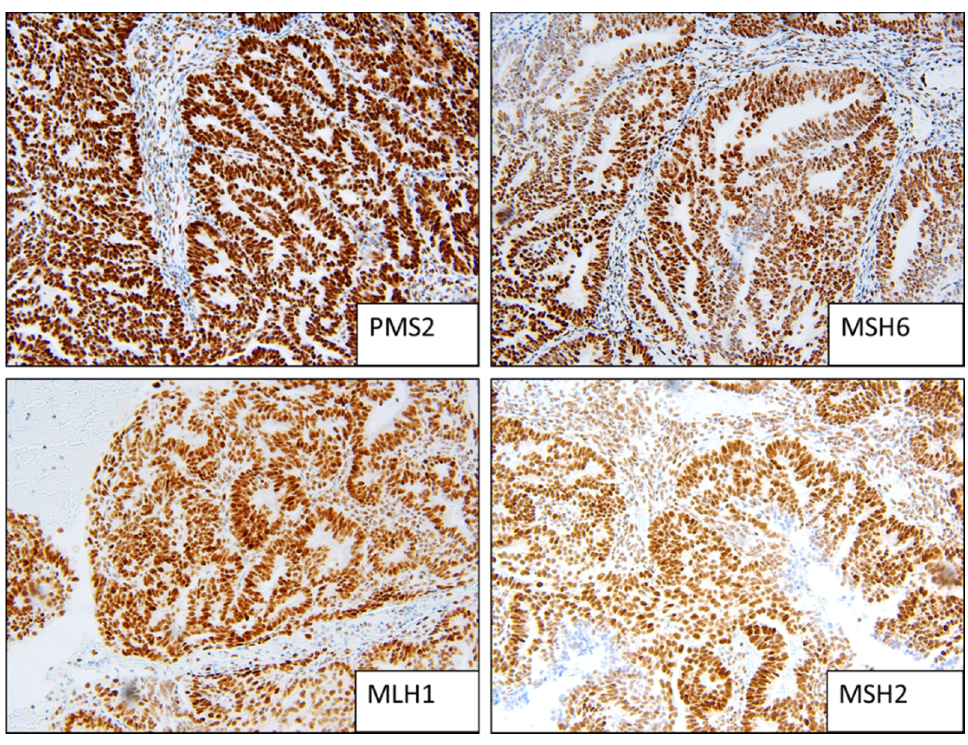
Figure 1. Example of MMR stable staining patterns (strong positive).